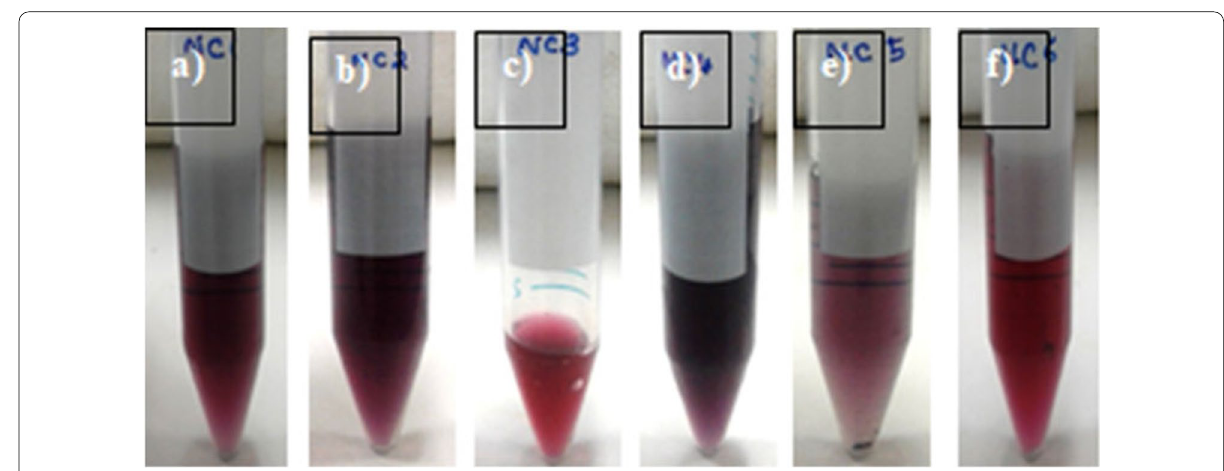
Fig. 5 a – f Synthesized nanoconjugates using trio